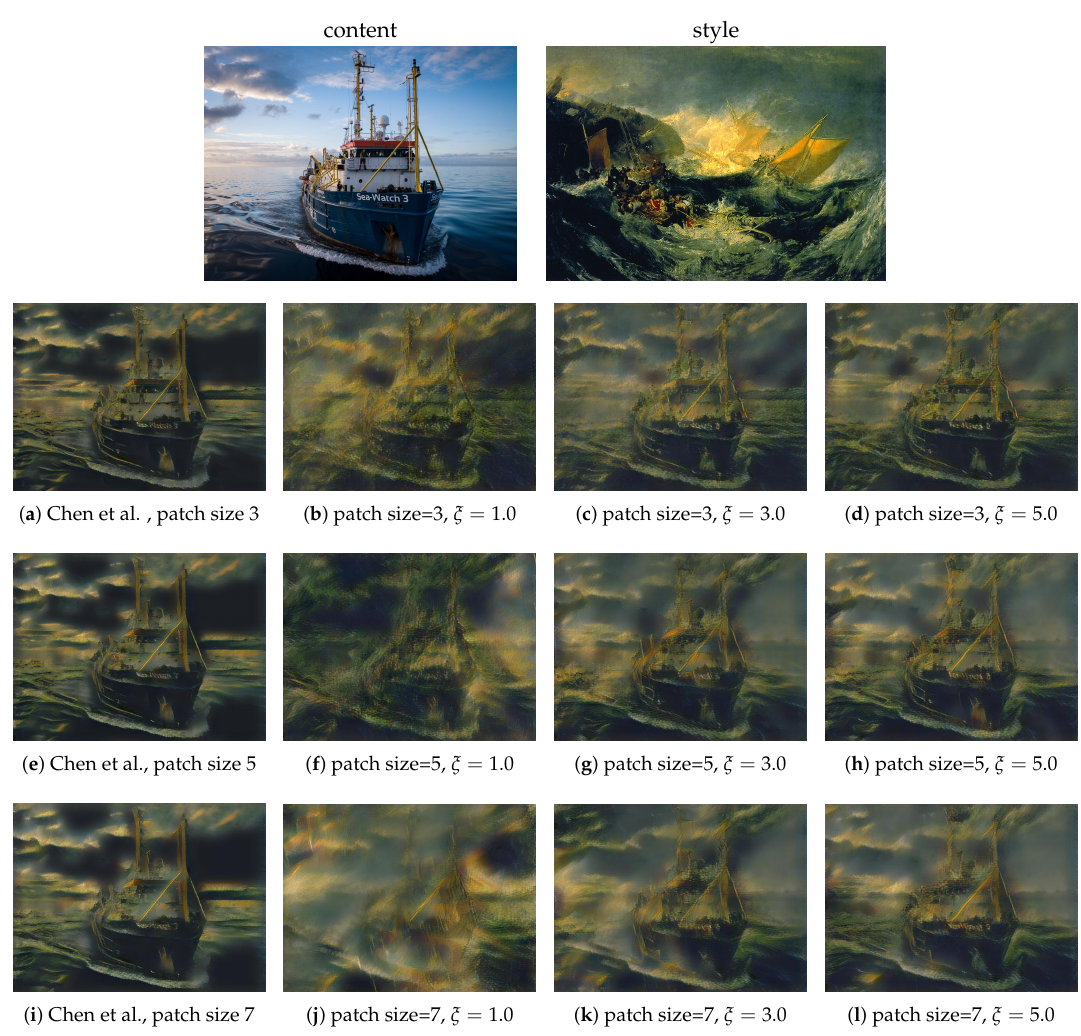
Figure 9. Style tuning by changing parameters of patch size and ξ